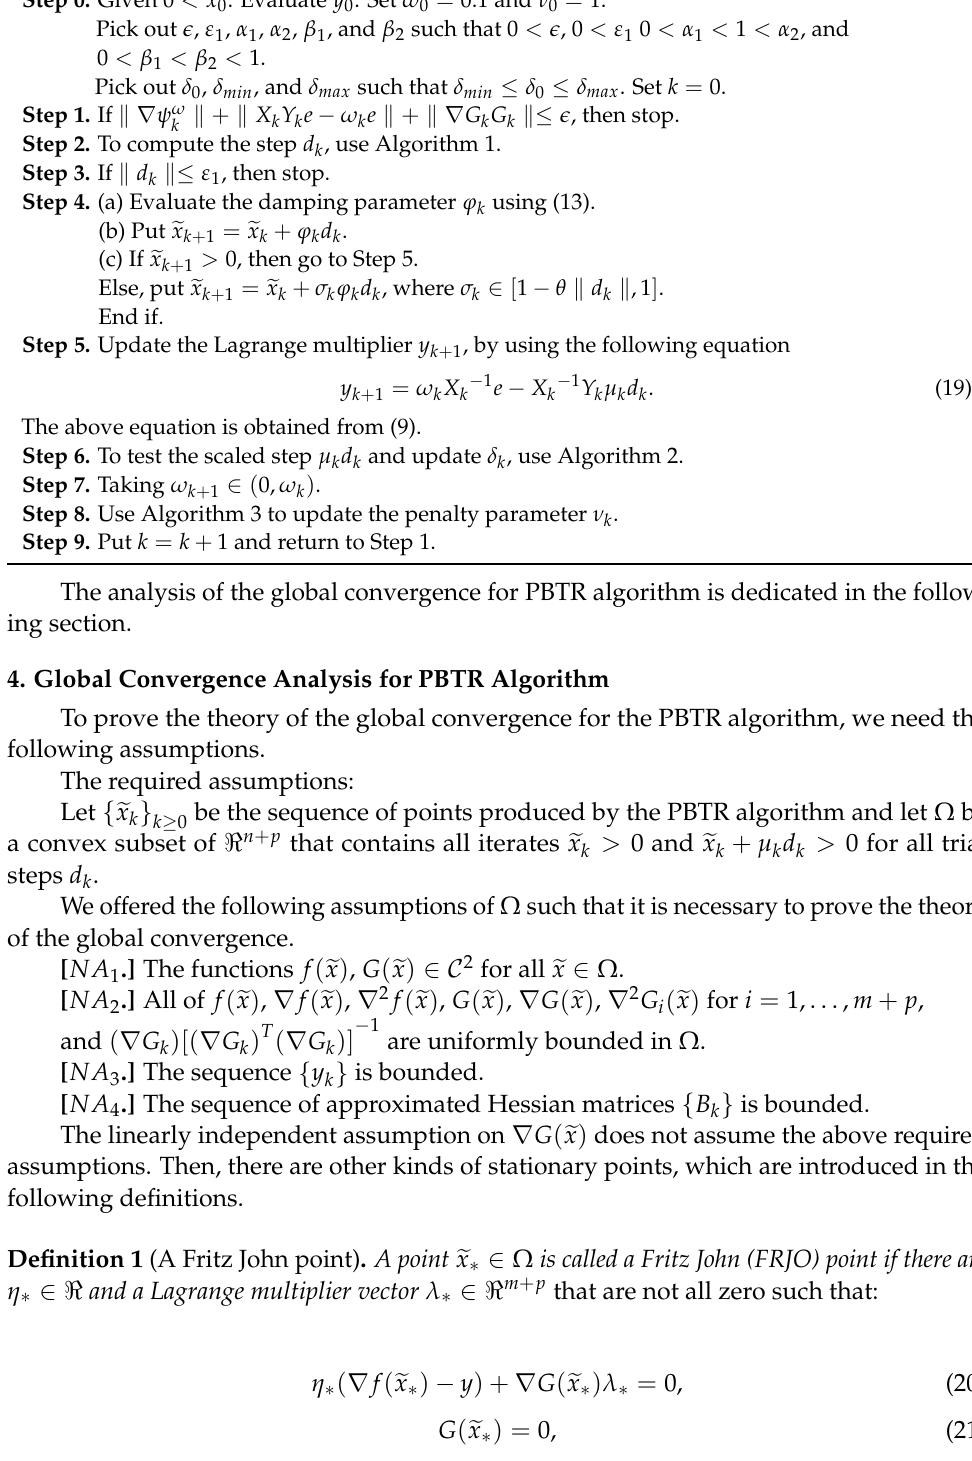
Algorithm 4 PBTR